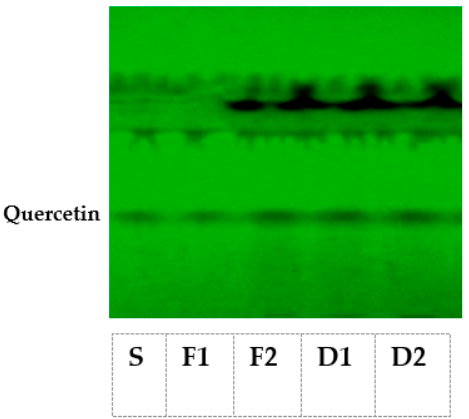
Figure 1. HPTLC chromatogram of T. officinale leaf extracts. S represents quercetin standard, F1 and F2 represent quercetin from fresh T. officinale leaf extracts, and D1 and D2 represent quercetin from shade-dried T. officinale leaf extracts.